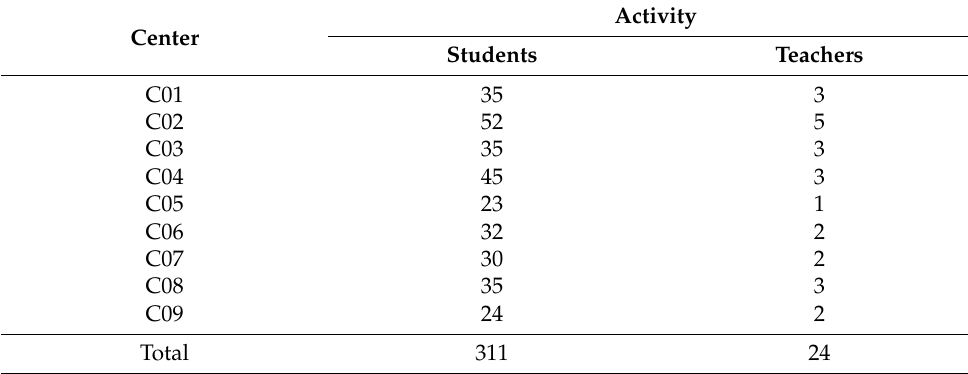
Table 2. Centers, teachers, and students participating in the activity. Center